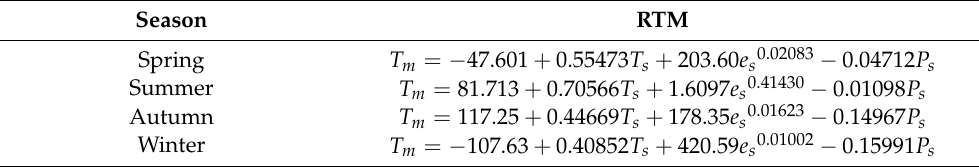
Table 10. The nonlinear seasonal three-factor RTMs in the Yangtze River Delta region during 2015–2016.